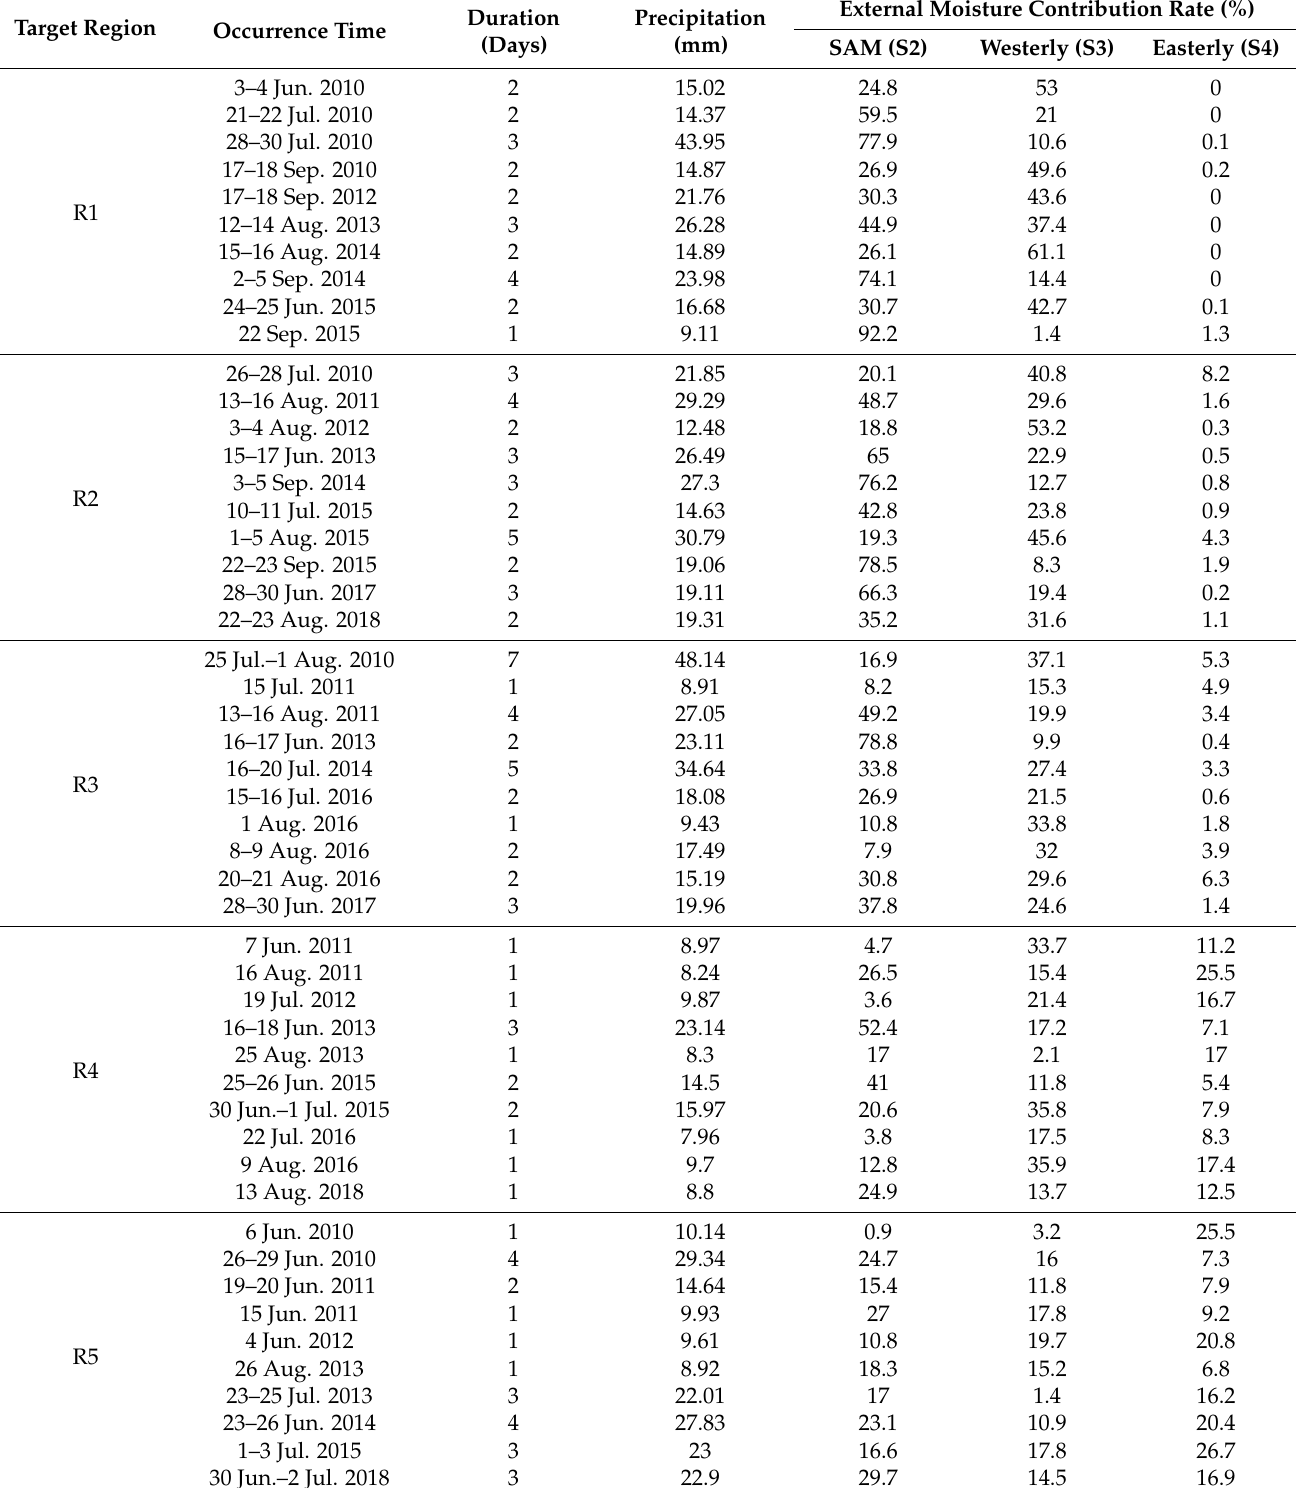
Table 1. Information of the top ten extreme precipitation events in each target region, including the precipitation date, precipitation amount, external moisture contribution rate of each precipitation event,